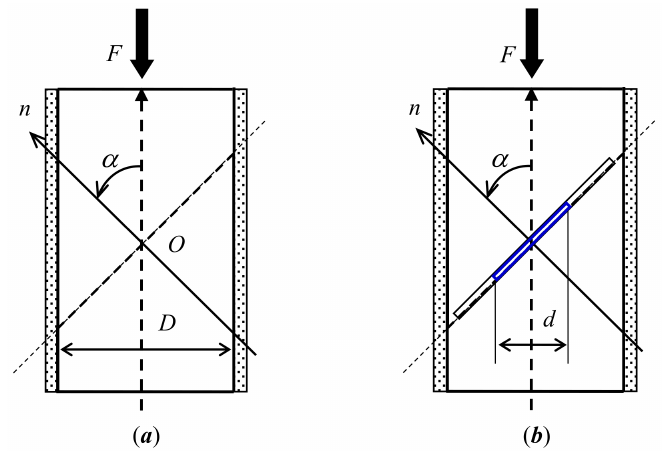
Figure A1. Flow stress of a micro-pillar is under uniaxial compression: boundary and inclusion effect, ( a ) perfect pillar with surface effect; ( b ) equivalent damaged pillar with surface effect, considering the weak